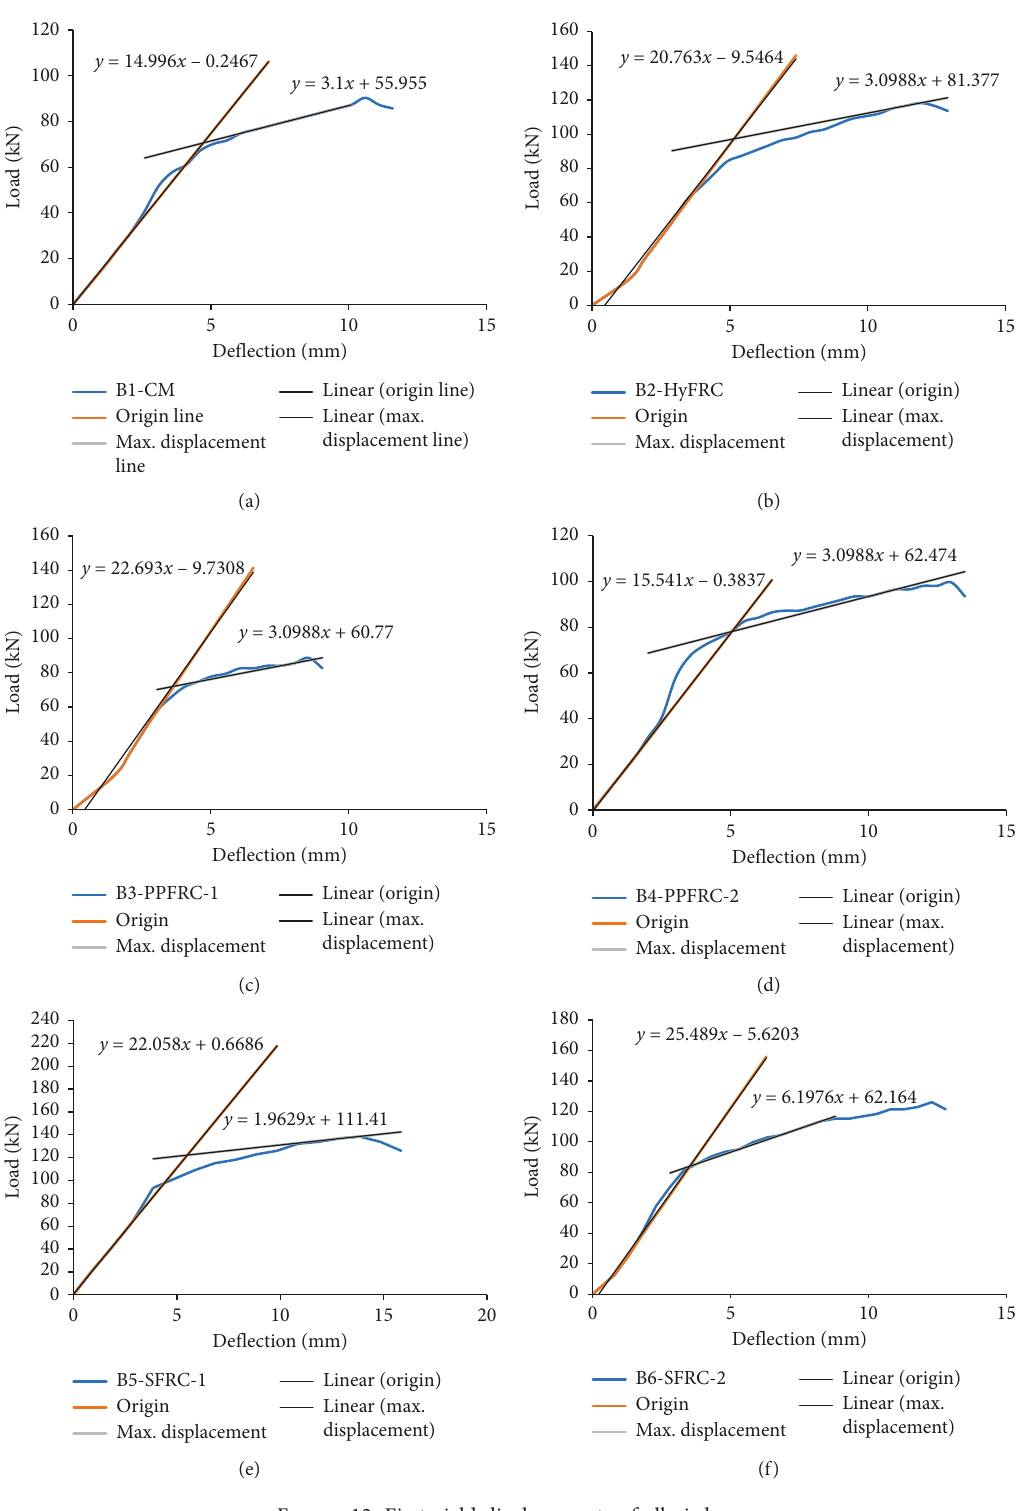
Figure 12: First yield displacements of all